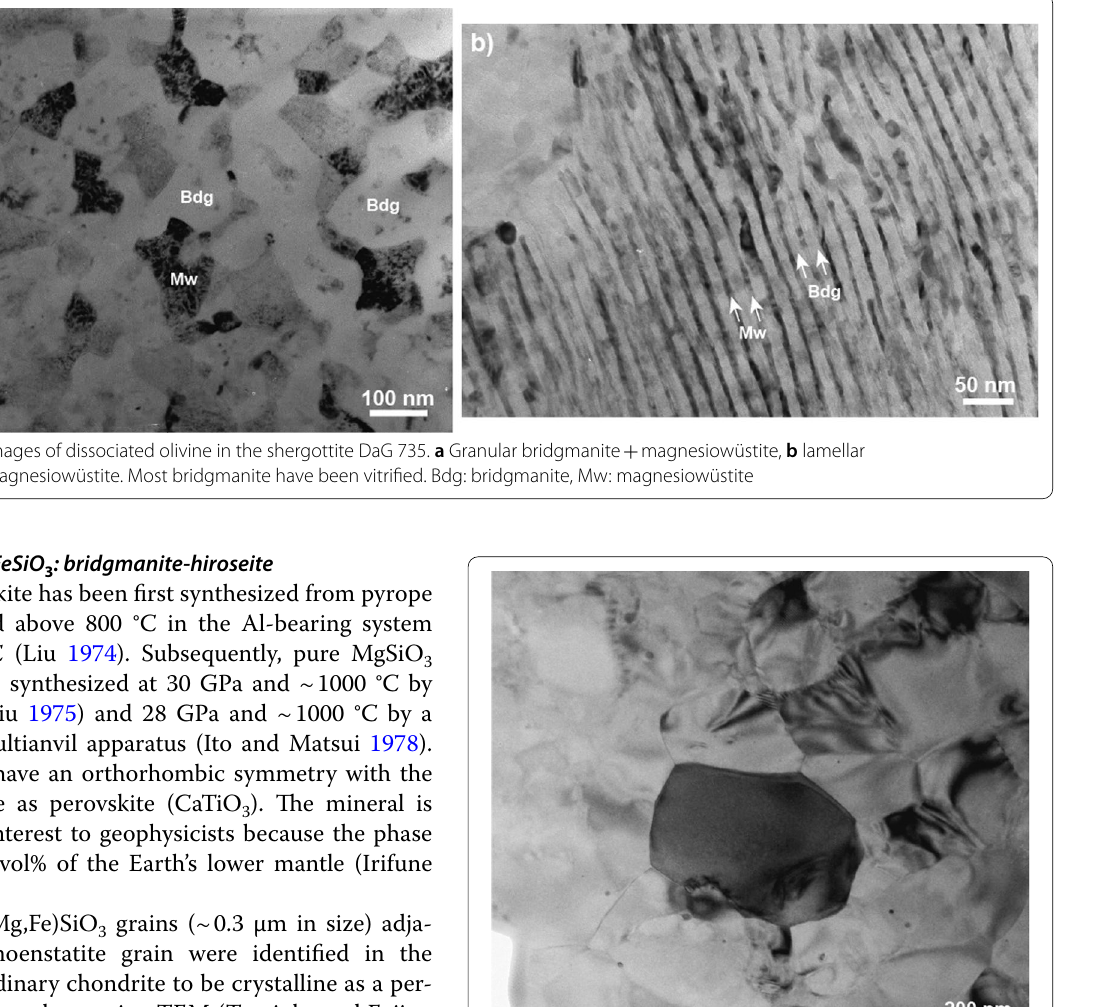
Fig. 7 BF-TEM image of a monomineralic aggregate of tetragonal majorite in the Tenham L6 ordinary chondrite. The majorite grains formed in a solid-state transformation of low-Ca pyroxene entrapped into a shock-melt